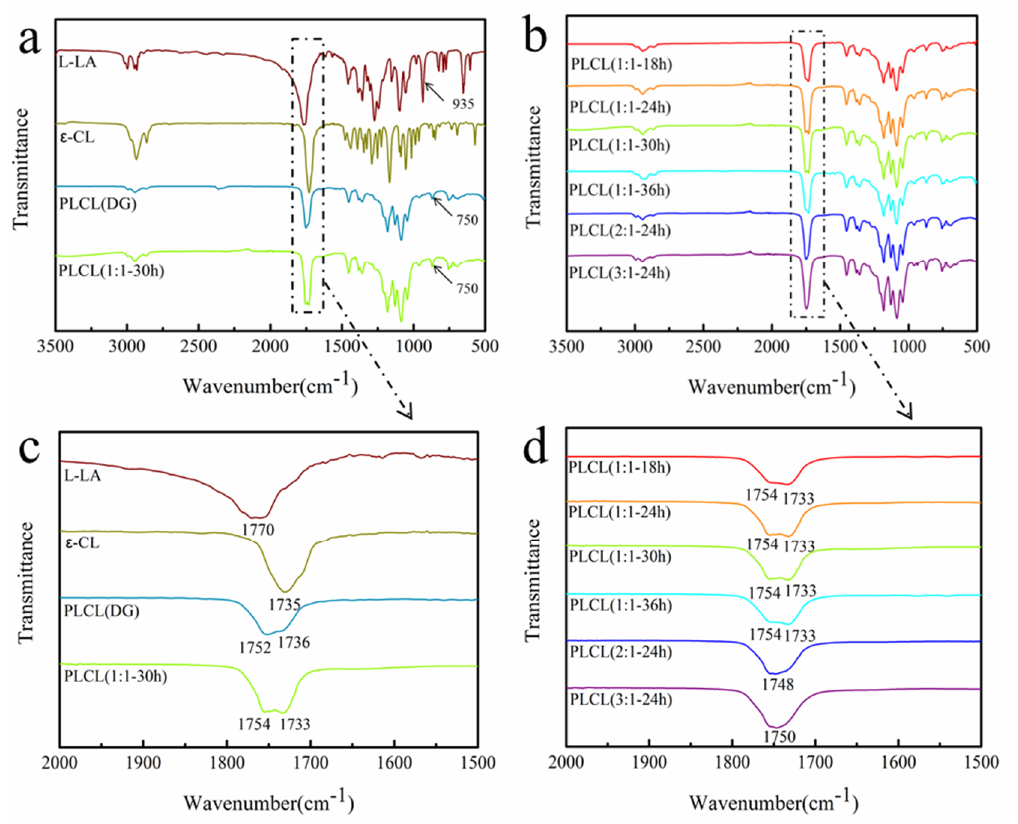
Figure 3. FT-IR spectra of L-LA, ε-CL, PLCL (DG) and PLCL (1:1-30h) ( a ); FT-IR spectra of PLCL copolymers synthesized under different conditions ( b ); FT-IR spectra of L-LA, ε-CL, PLCL (DG) and PLCL (1:1-30h) in the region of 1500 to 2000 cm −1 ( c ); FT-IR spectra of PLCL copolymers synthesized under different conditions in the region of 1500 to 2000 cm −1 ( d ).